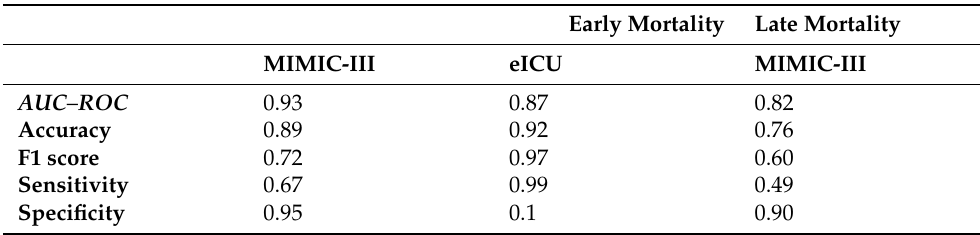
Figure 6. ROC curves for late mortality in ICU patients with thrombosis from MIMIC-III database using all features: ( a ) AUC – ROC curves and comparison with clinical scores. ( b ) PR curve. Table 4. Detailed metrics of performance for prediction of early and late mortality of ICU patients with thrombosis using all